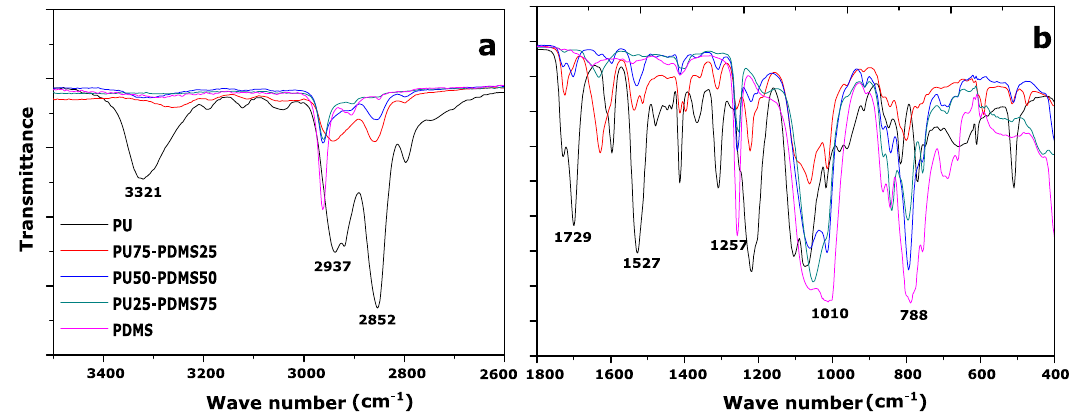
Figure 2: FTIR graph of PU – PDMS coatings ( a ) from 3500 to 2600, and ( b ) from 1800 –